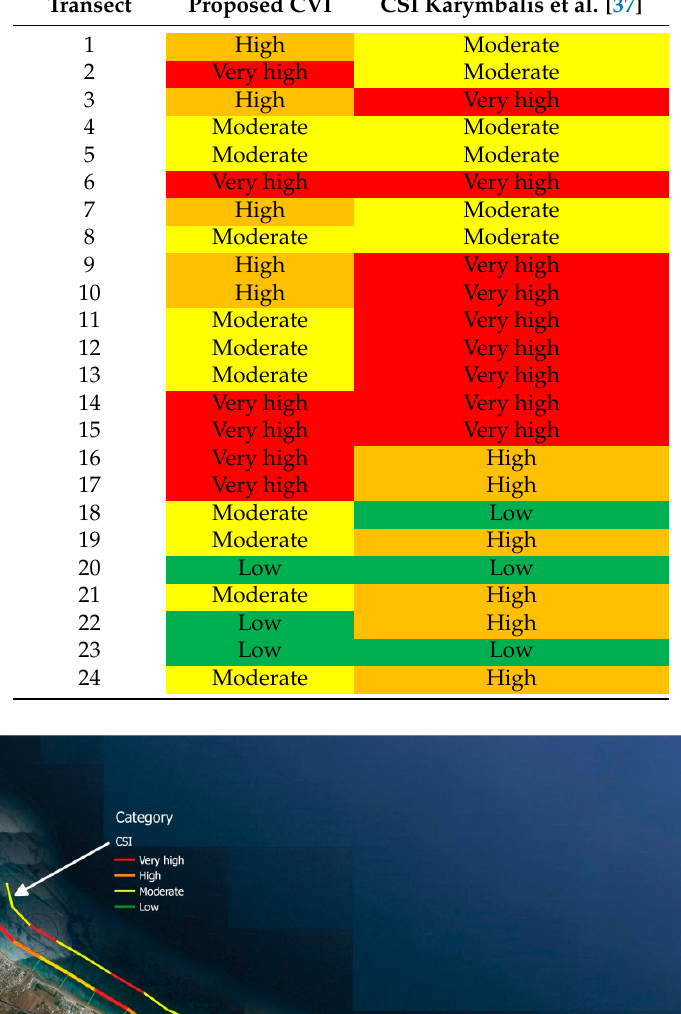
Table 4. Comparison between the proposed CVI and the CSI.